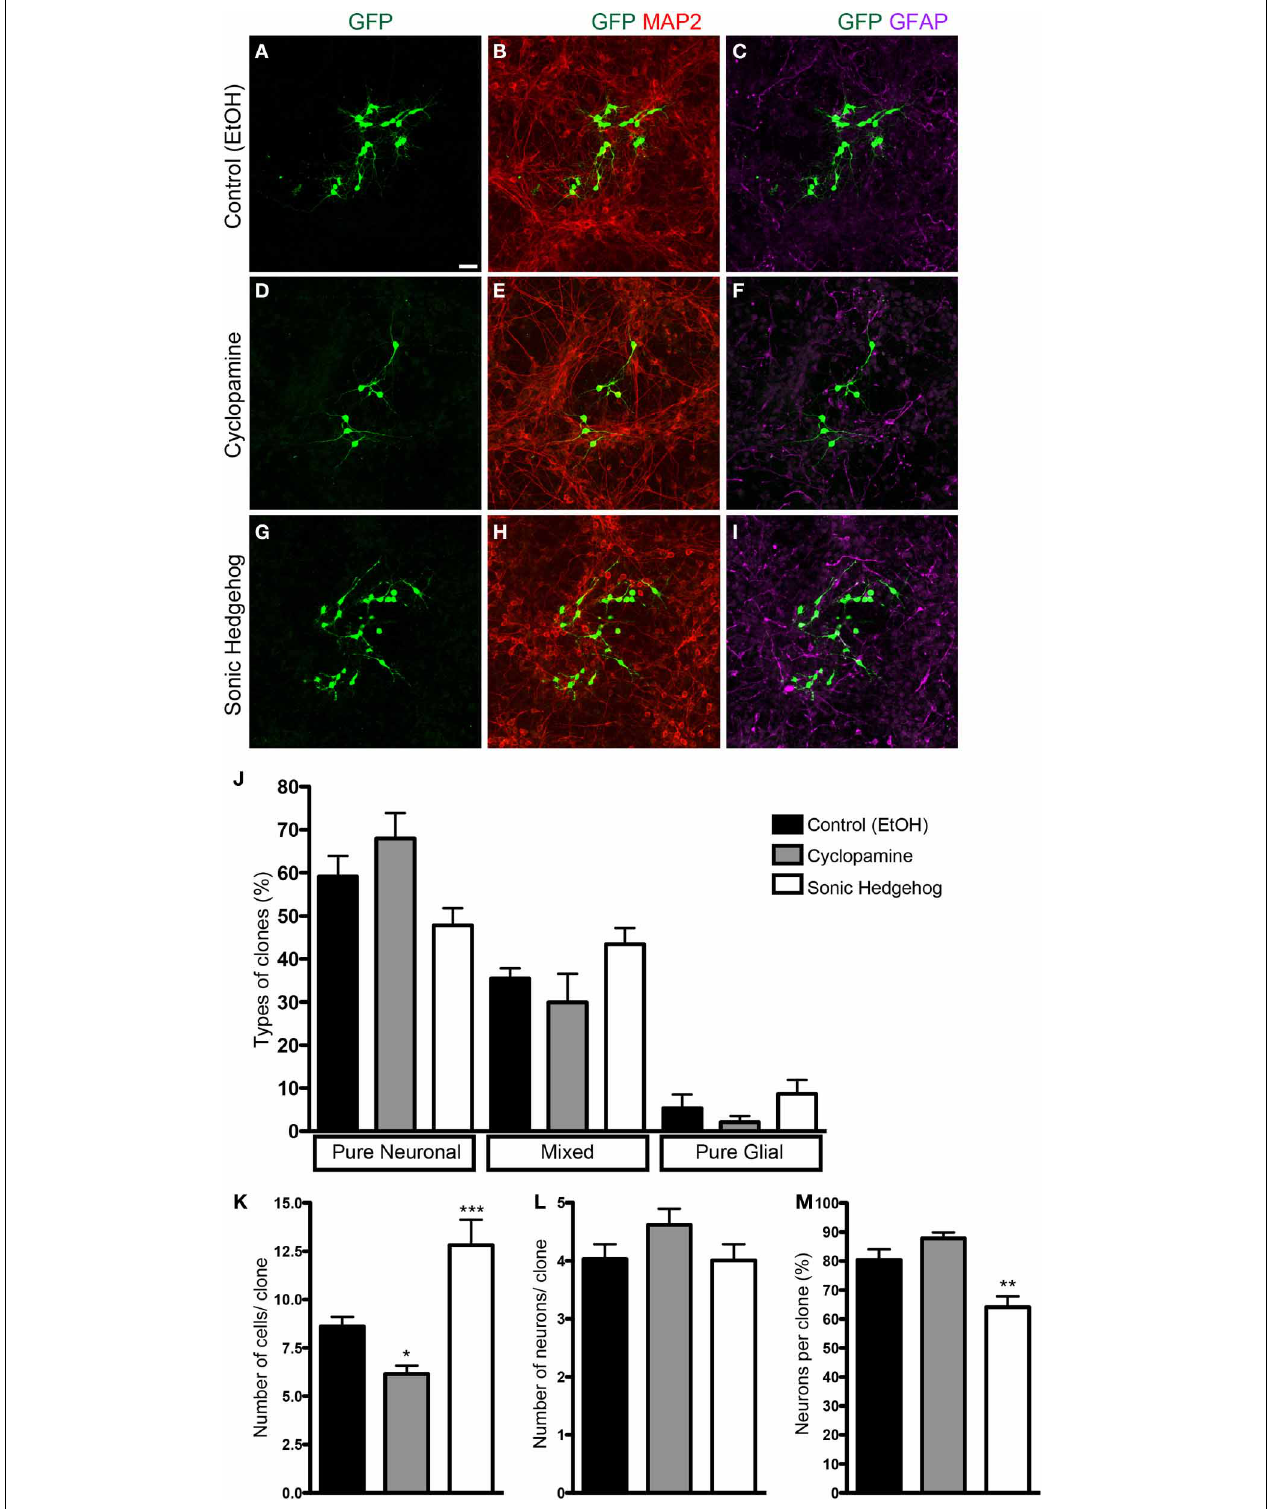
FIGURE 2 | Clonal analysis using retroviral vectors. (A–I) Images of cortical cell cultures after 7 div, immunolabeled with antibodies against GFP (green), MAP-2 (red), and GFAP (magenta). (J) Quantification of the types of clones in different conditions. (K–M) Quantifications of total number of cells (K) , number of neurons (L) , and percentage of neurons (M) per clone. Note